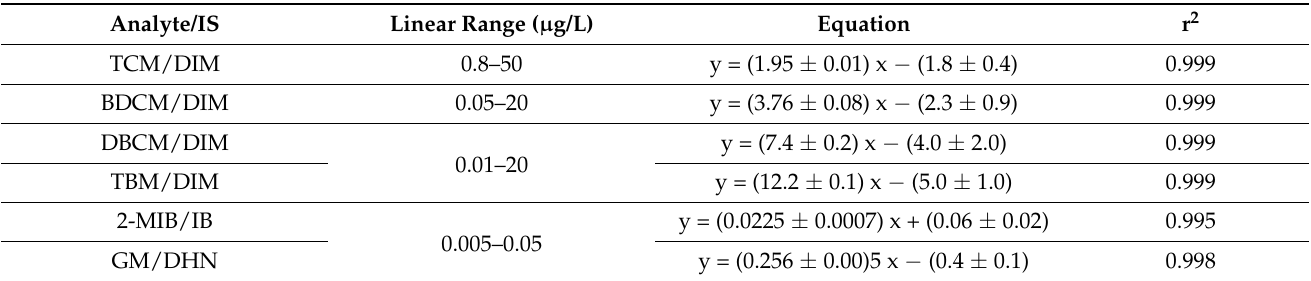
Table 4. Linearity concentration ranges of THM and T&Os.